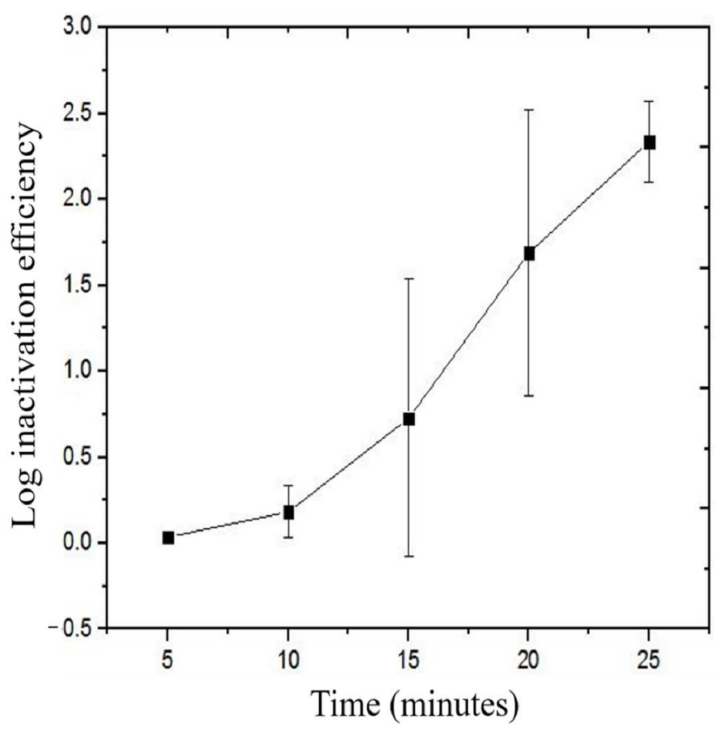
Figure 10. Bacterial removal efficiency of E. coli